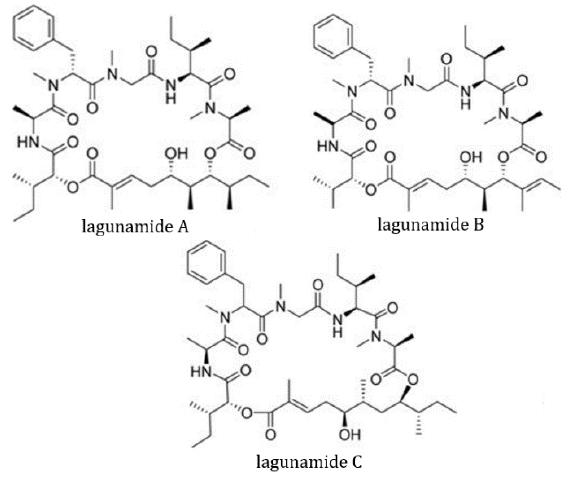
Figure 12. Structures of lagunamides A-C